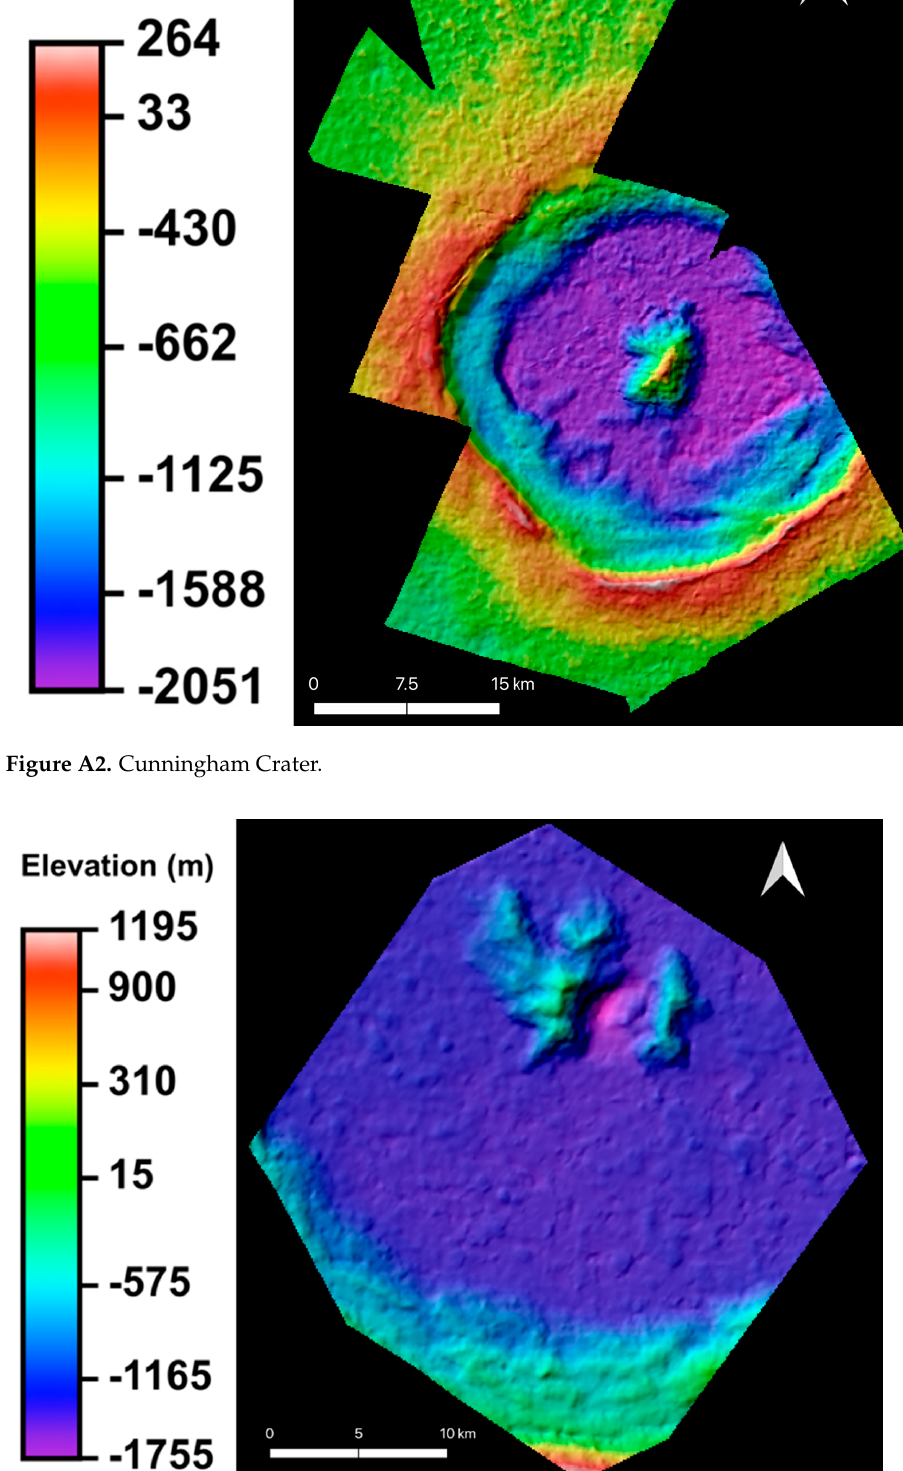
Figure A3. Degas Crater.